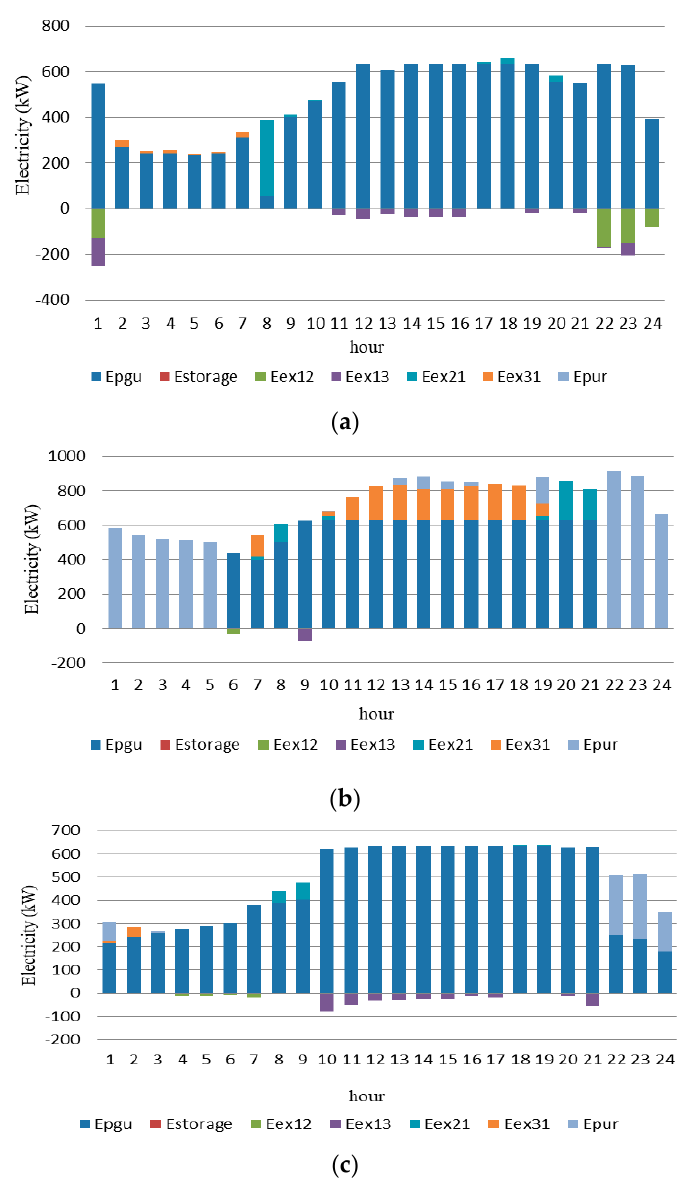
Figure 6. Hourly electricity balance of hotels in typical winter ( a ), summer ( b ) and mid-season days ( c ).